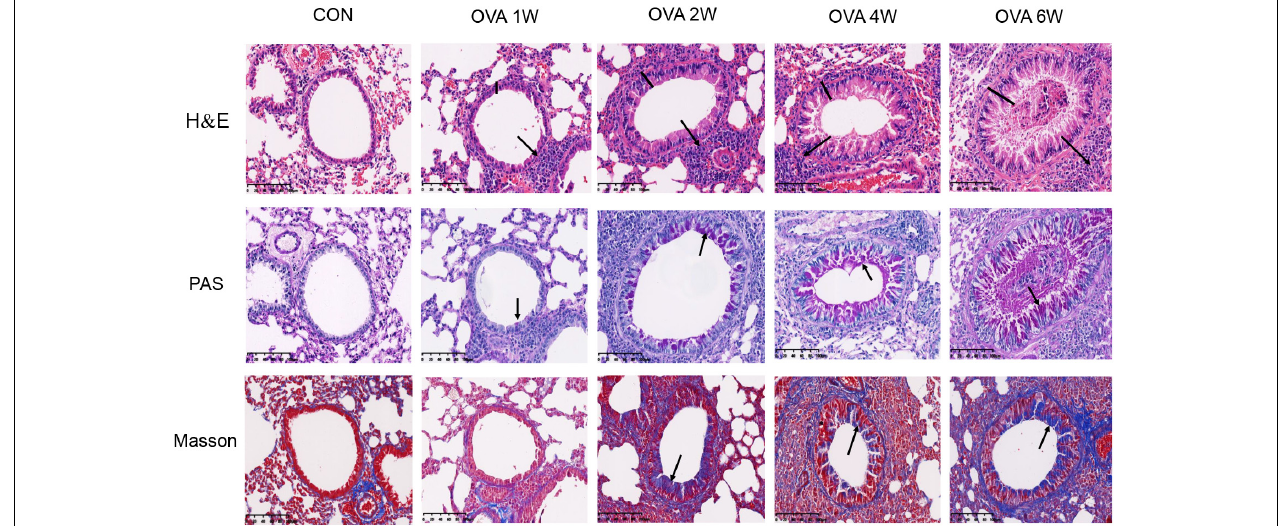
FIGURE 2 | Changes in the pulmonary pathology of mice with OVA-induced chronic asthma. Representative hematoxylin and eosin (H&E)-stained lung sections showing inflammatory cell infiltration around the small airways, bronchial wall thickening, and constriction (200 × ; the black arrows indicate the aggregation of inflammatory cells, and the black vertical line indicates the airway wall thickness). PAS staining indicating the mucus-producing goblet cells around the small airways (200 × ; similar to the purple area indicated by the black arrow). Masson’s trichome staining indicating collagen fiber deposition around small airways (200 × ; similar to the blue area indicated by the black